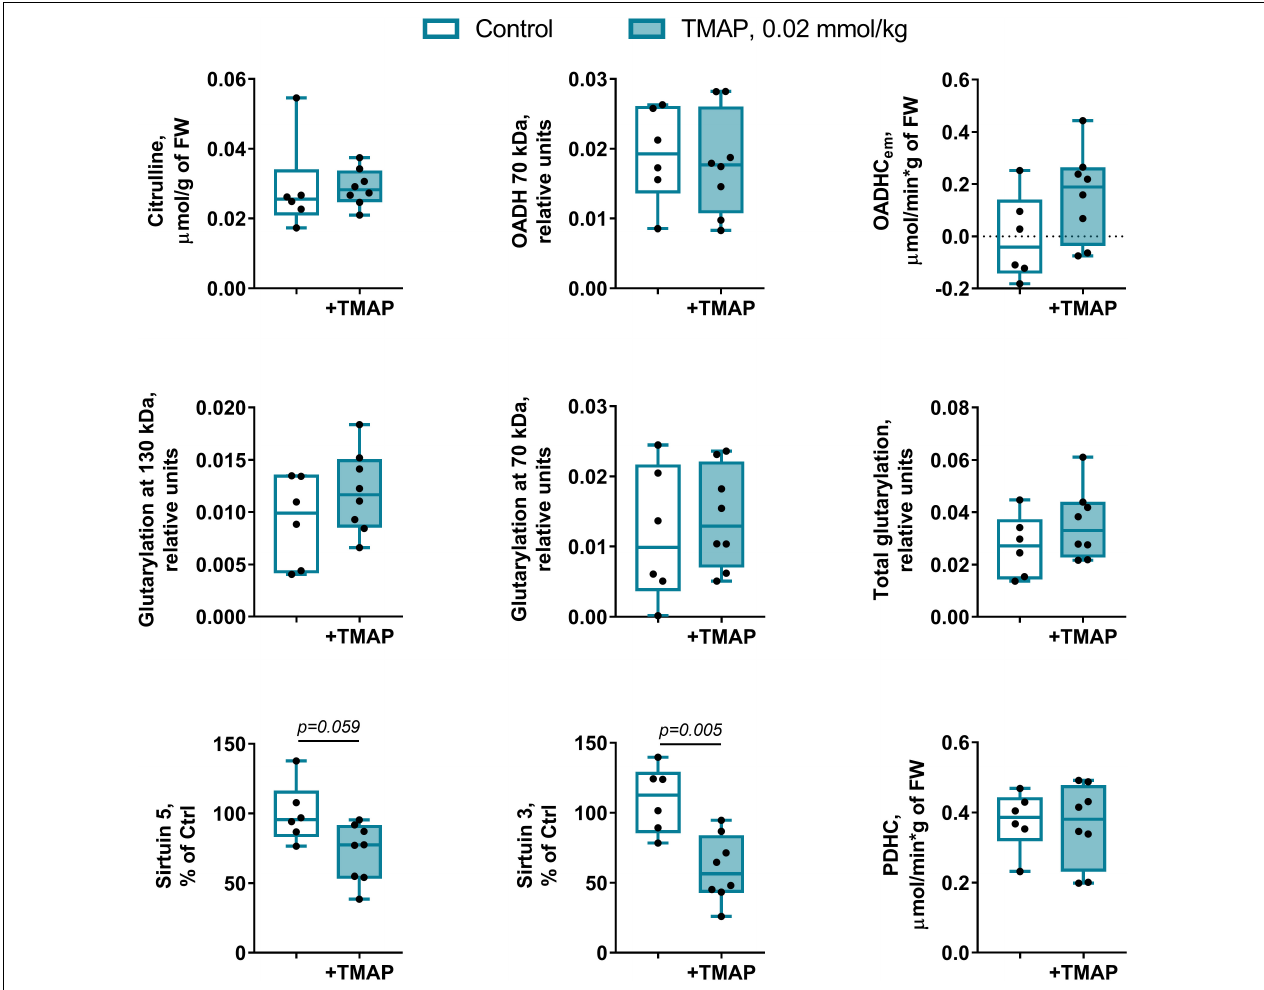
FIGURE 9 | Short-term changes in the protein glutarylation system of the brain cortex 24 h after TMAP administration to the control rats. Representative Western blots for estimation of relative glutarylation and protein levels are shown in Supplementary Figure 6 . Statistical significance of the differences between experimental groups is determined by unpaired Mann-Whitney test, with p -values < 0.10 shown on the